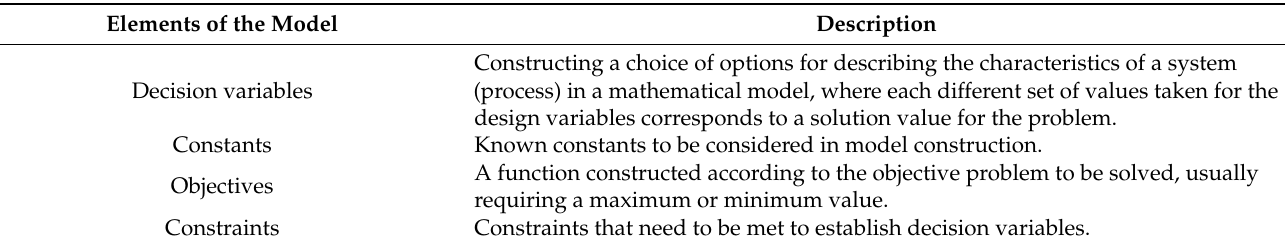
Table 1. Components of a multi-objective optimization model.